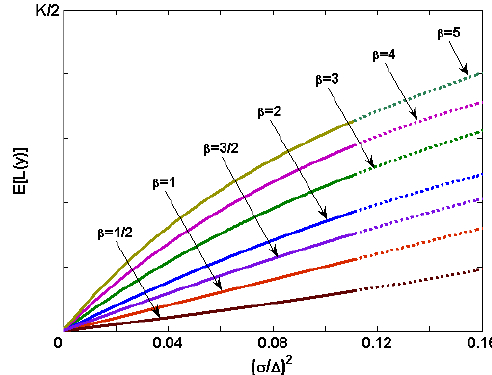
Figure 9. Expected loss for the PLF vs. relative